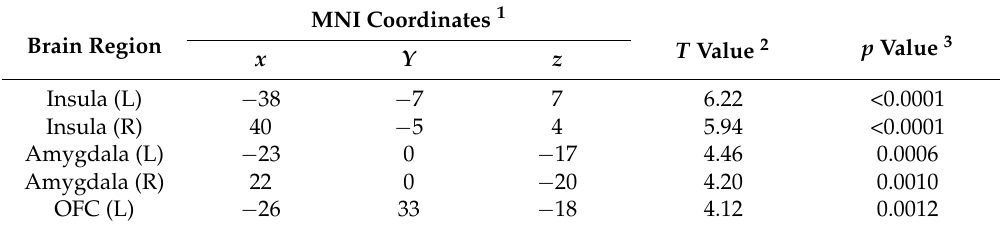
Table 3. Responses to visual food cues compared to nonfood cues in the fasting-state on Day 1.